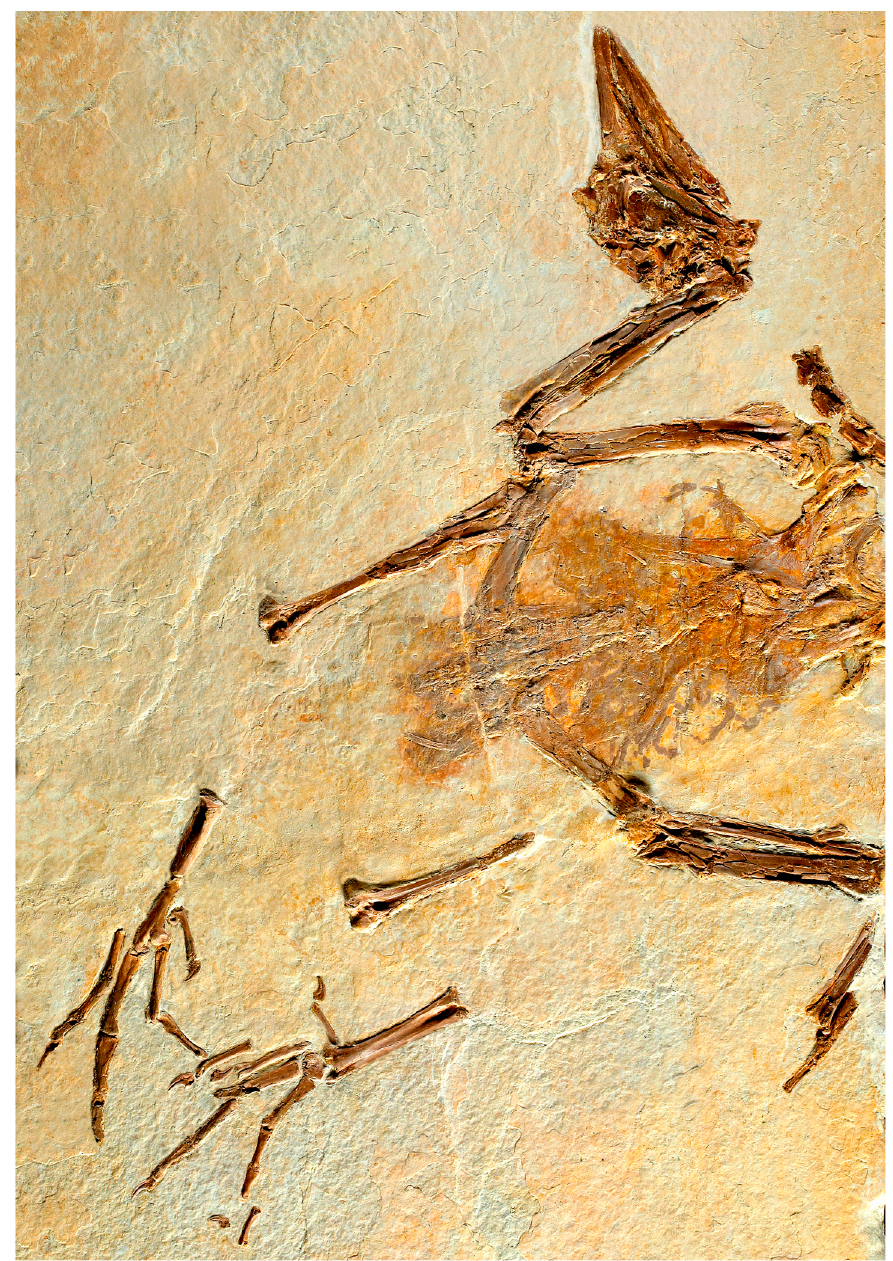
Figure 4. Screamer-like anseriform (Anseriformes familia incertae sedis, FMNH PA725), essentially complete two-dimensional skeleton on a slab from the Fossil Butte Member of the Green River Formation [117] (figure 120; reproduced courtesy of Lance Grande).